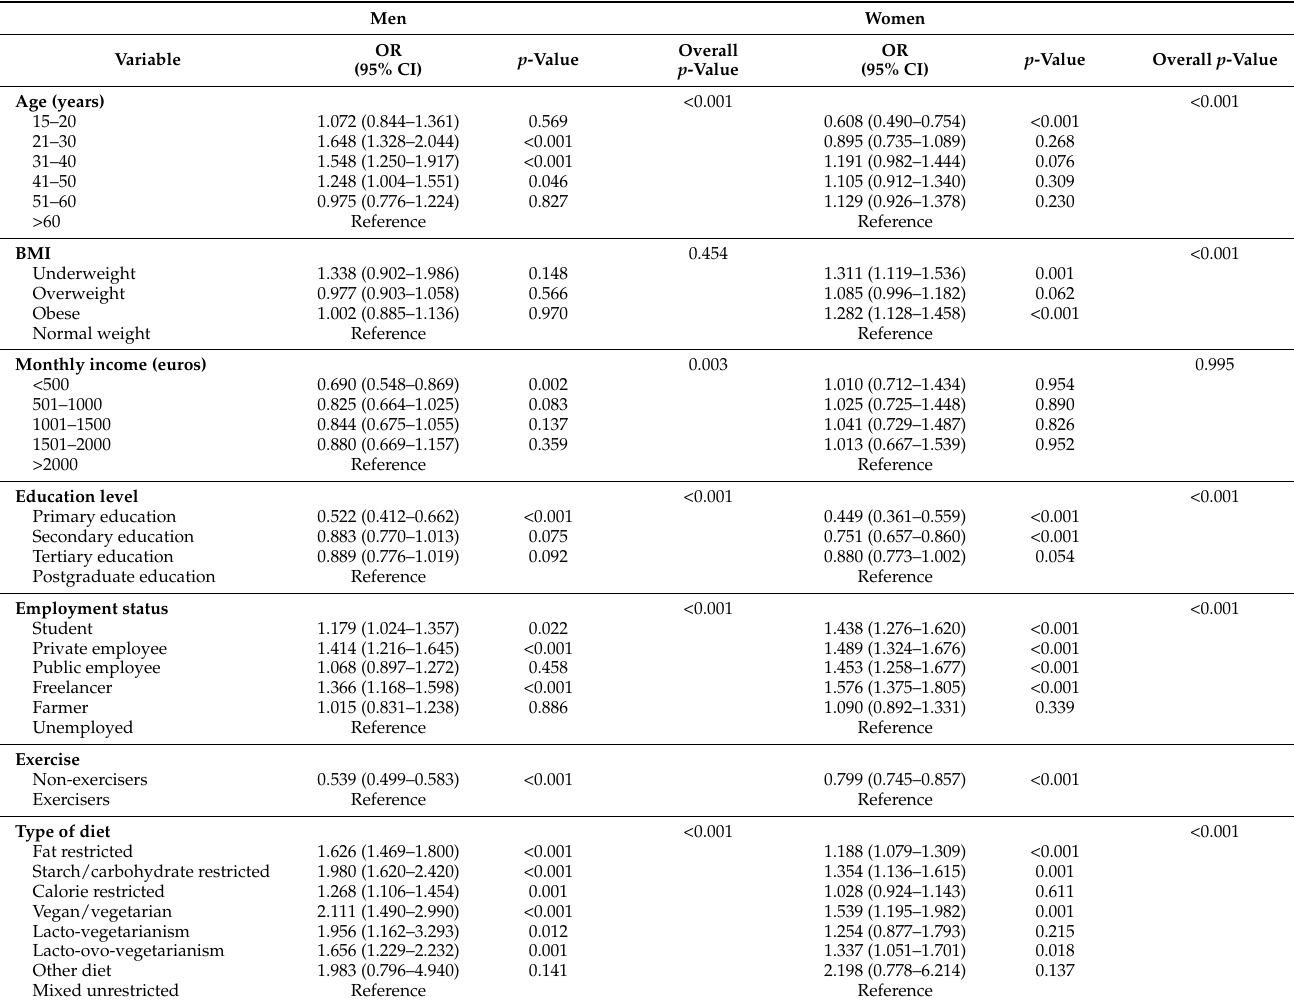
Table 7. Wald’s test p -values adjusted OR and 95% confidence interval (CI) for the association between men and women DS users the independent